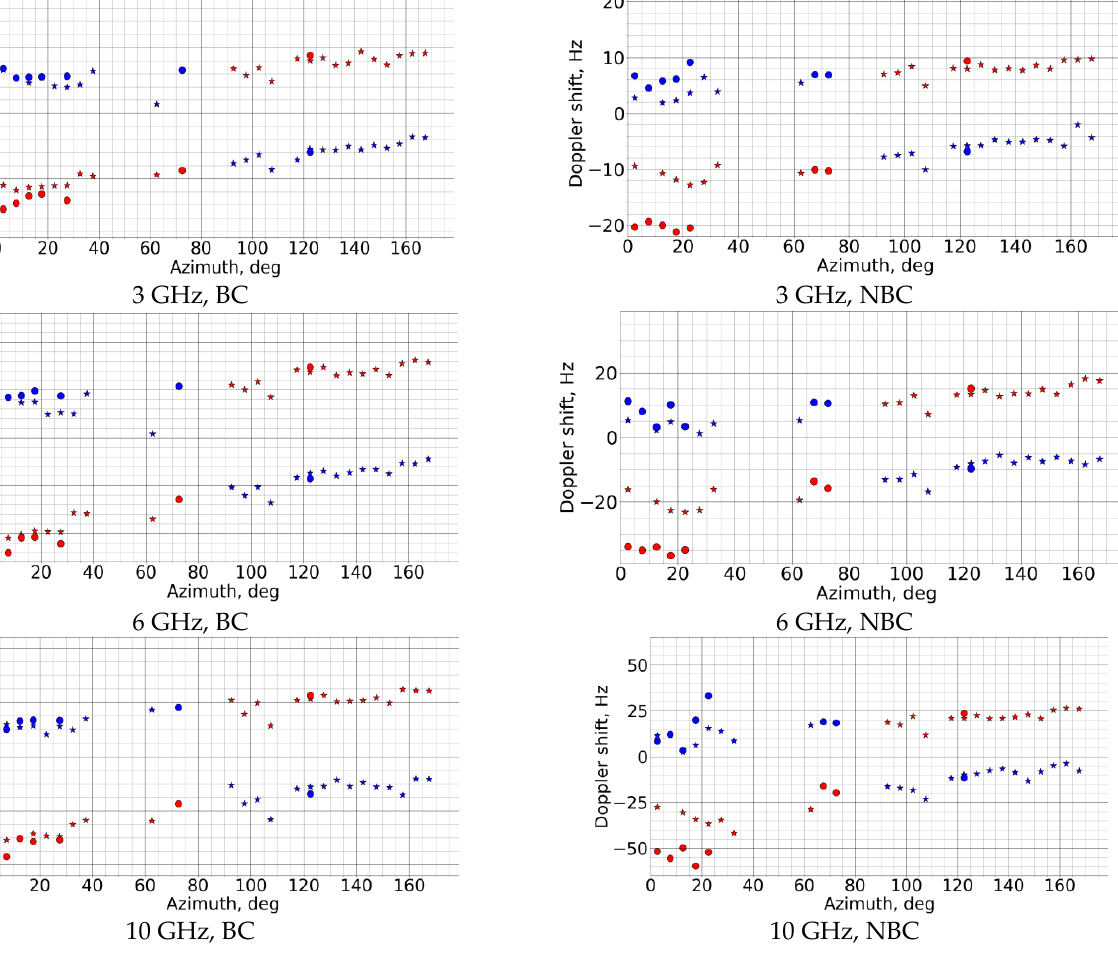
Figure 9. Radar Doppler shifts for BC and NBC as functions of azimuth angle. Red symbols — scatterers moving downwind, blue symbols—against the wind, stars, and circles correspond to wind velocities of 6 – 7 m/s, and 10 – 11 m/s, respectively.